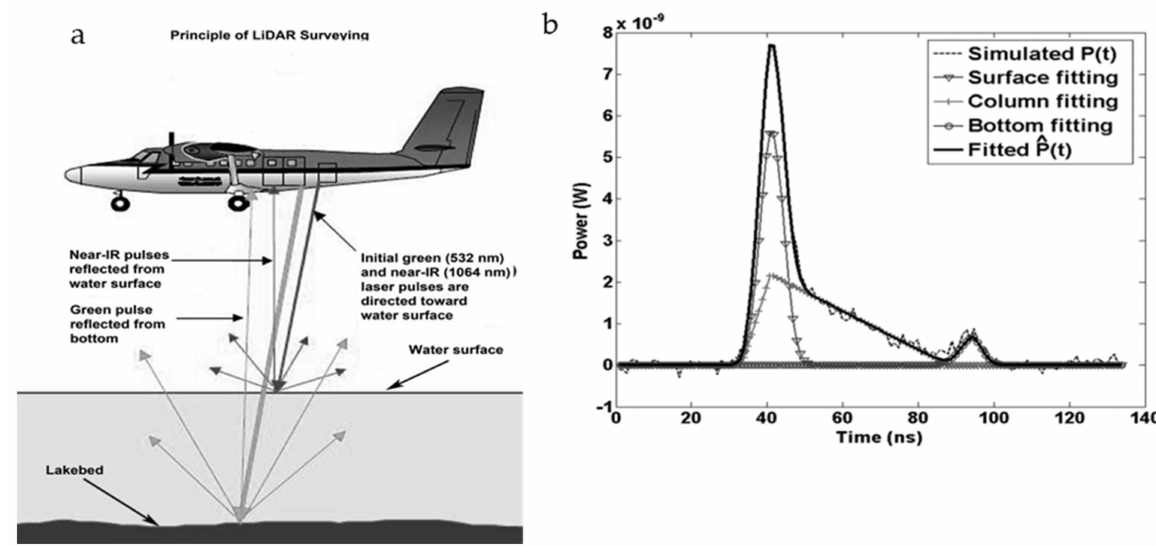
Figure 5. For LiDAR, two laser pulses (blue-green 532 nm and near-IR 1,064 nm) sweep across the lake surface: ( a ) the near-IR reflects off the water surface, whereas the blue-green penetrates through the water column and reflects off the lakebed. The difference between the two returning pulses gives the depth of the water column and details of bathymetry (modified from [23]). ( b ) Simulated LiDAR waveform fitted with Gaussian function (water surface peak), a triangle function (water column reflectance), and a Weibull function for bottom reflectance (after